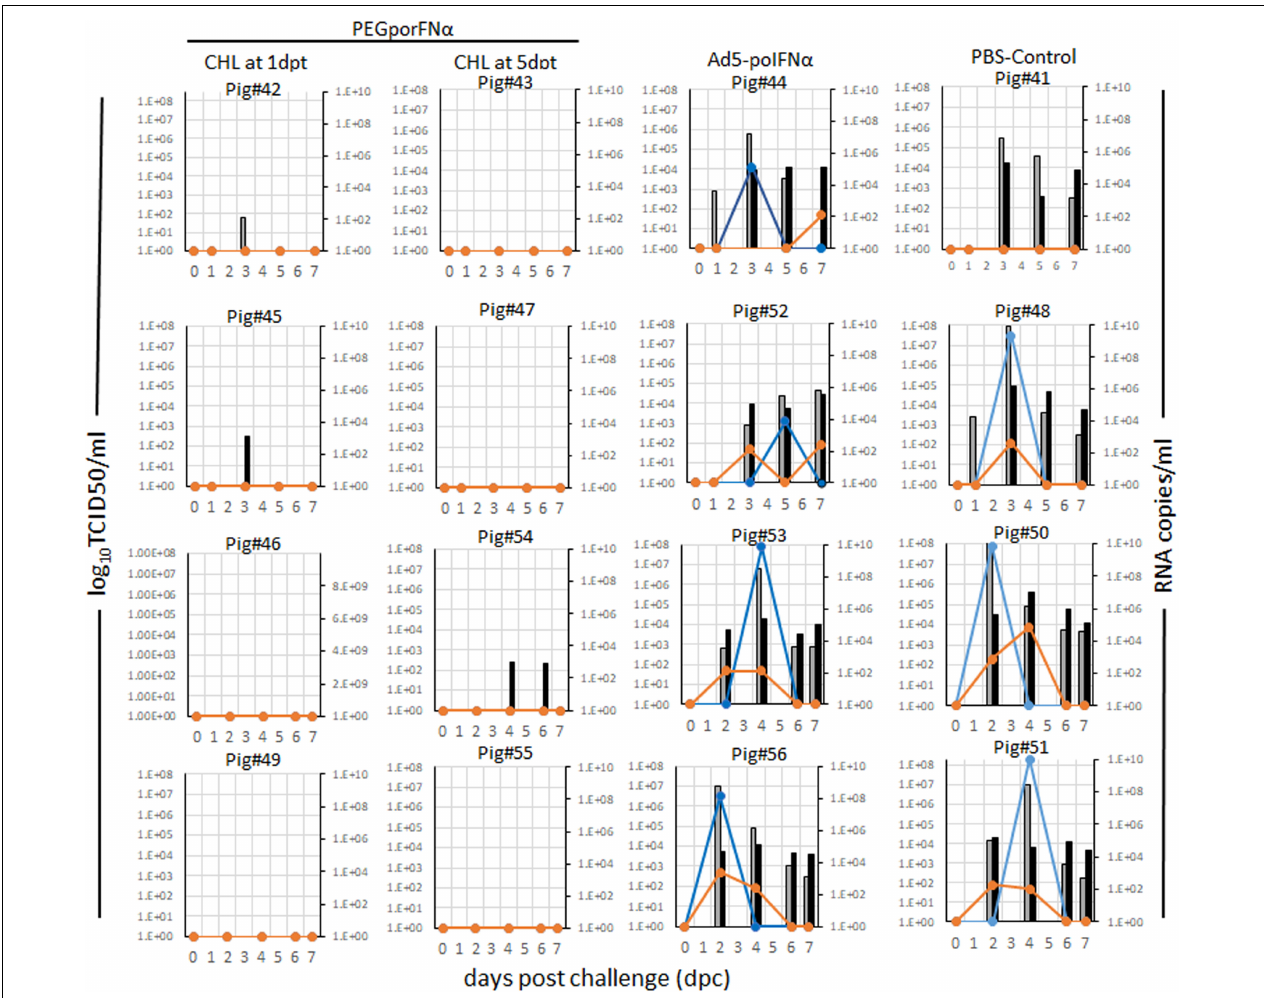
FIGURE 4 | Virus detection in serum and nasal swabs in animals inoculated with different viruses at indicated doses. 18–23 kg castrated male Yorkshire swine ( n = 4/group) challenged with FMDV A24Cru after indicated treatments (groups) were sampled for 7 days. The amount of virus was detected by virus isolation in serum (orange line) and nasal secretions (blue line) and by qPCR and expressed as RNA copy numbers per ml of serum (gray bars) or per ml of nasal secretions (black bars) are represented for each animal